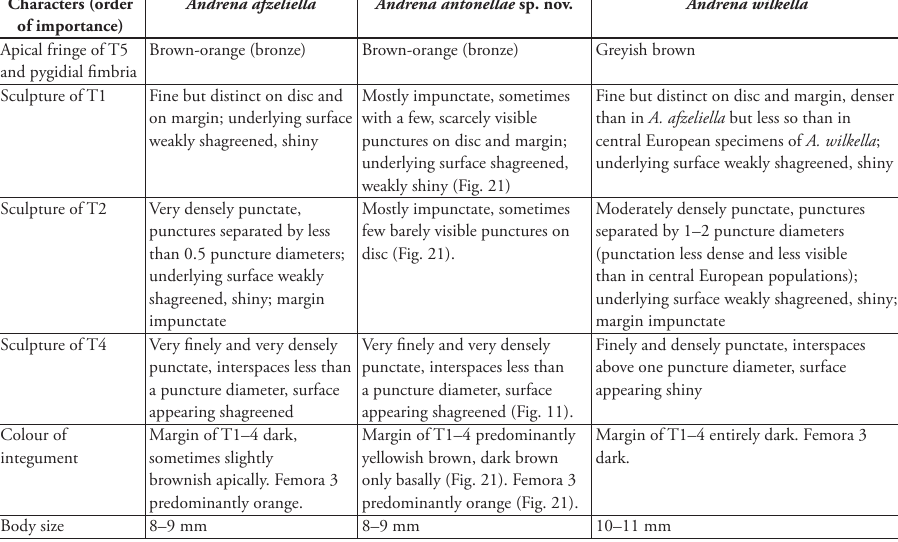
Table 2. Comparison of the females of Andrena antonellae sp. nov., and those of the populations of A. af- zeliella and A. wilkella from Corsica and Sardinia. Andrena wilkella has so far only been reported from Corsica. Characters (order of